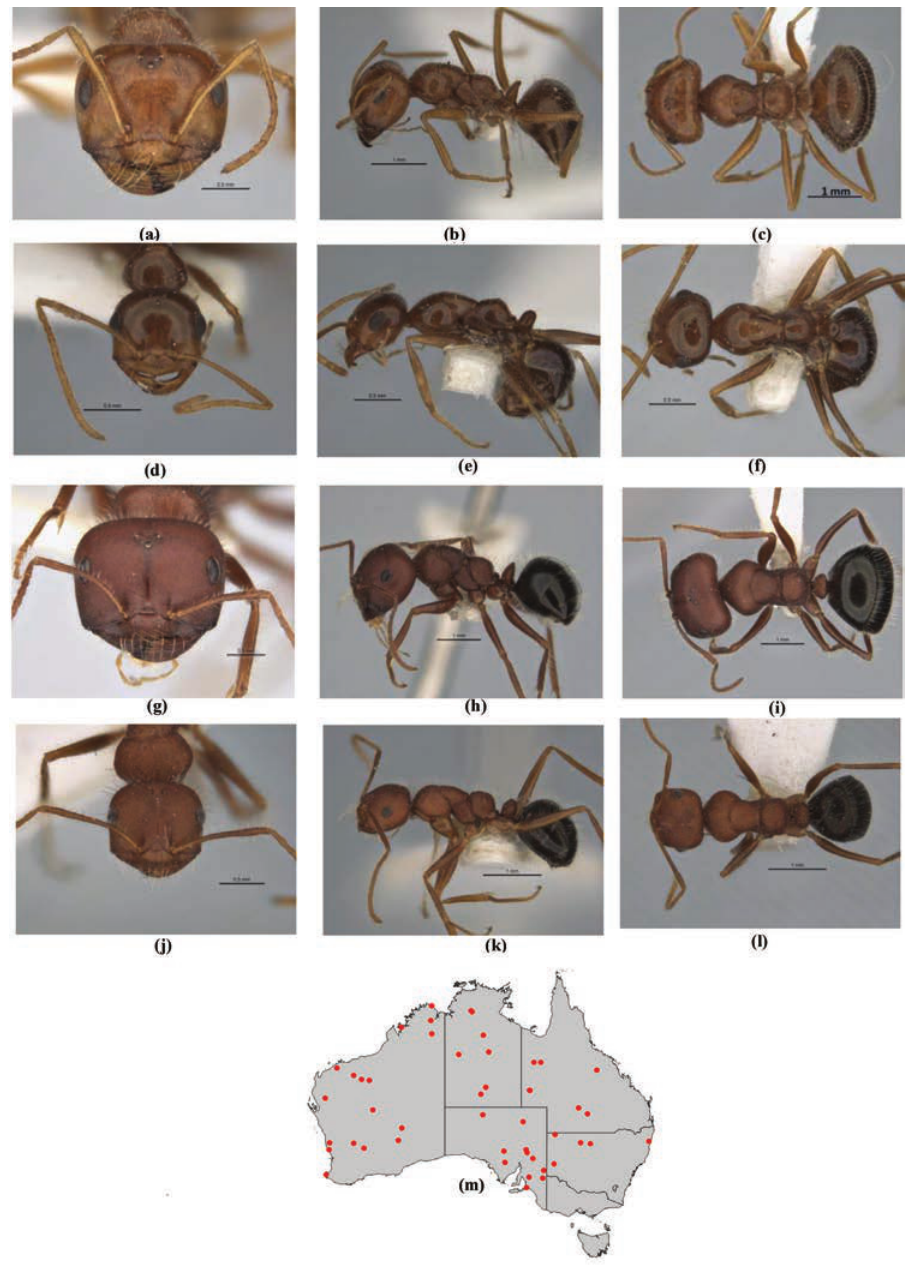
Figure 58. Melophorus hirsutipes sp. n.: major worker paratype (ANIC32-900147–top ant) frons ( a ), profile ( b ) and dorsum ( c ); minor worker holotype (ANIC32-066645–bottom ant) frons ( d ), profile ( e ) and dorsum ( f ); ‘ hispidus ’ form major worker (ANIC32-900093) frons ( g ), profile ( h ) and dorsum ( i ); ‘ hispidus ’ form minor worker (JDM32-004543) frons ( j ), profile ( k ) and dorsum ( l ) distribution map for the species ( m ). Low resolution scale bars: 1 mm ( b, h , j, k , l); 0.5 mm ( a, d–g, j